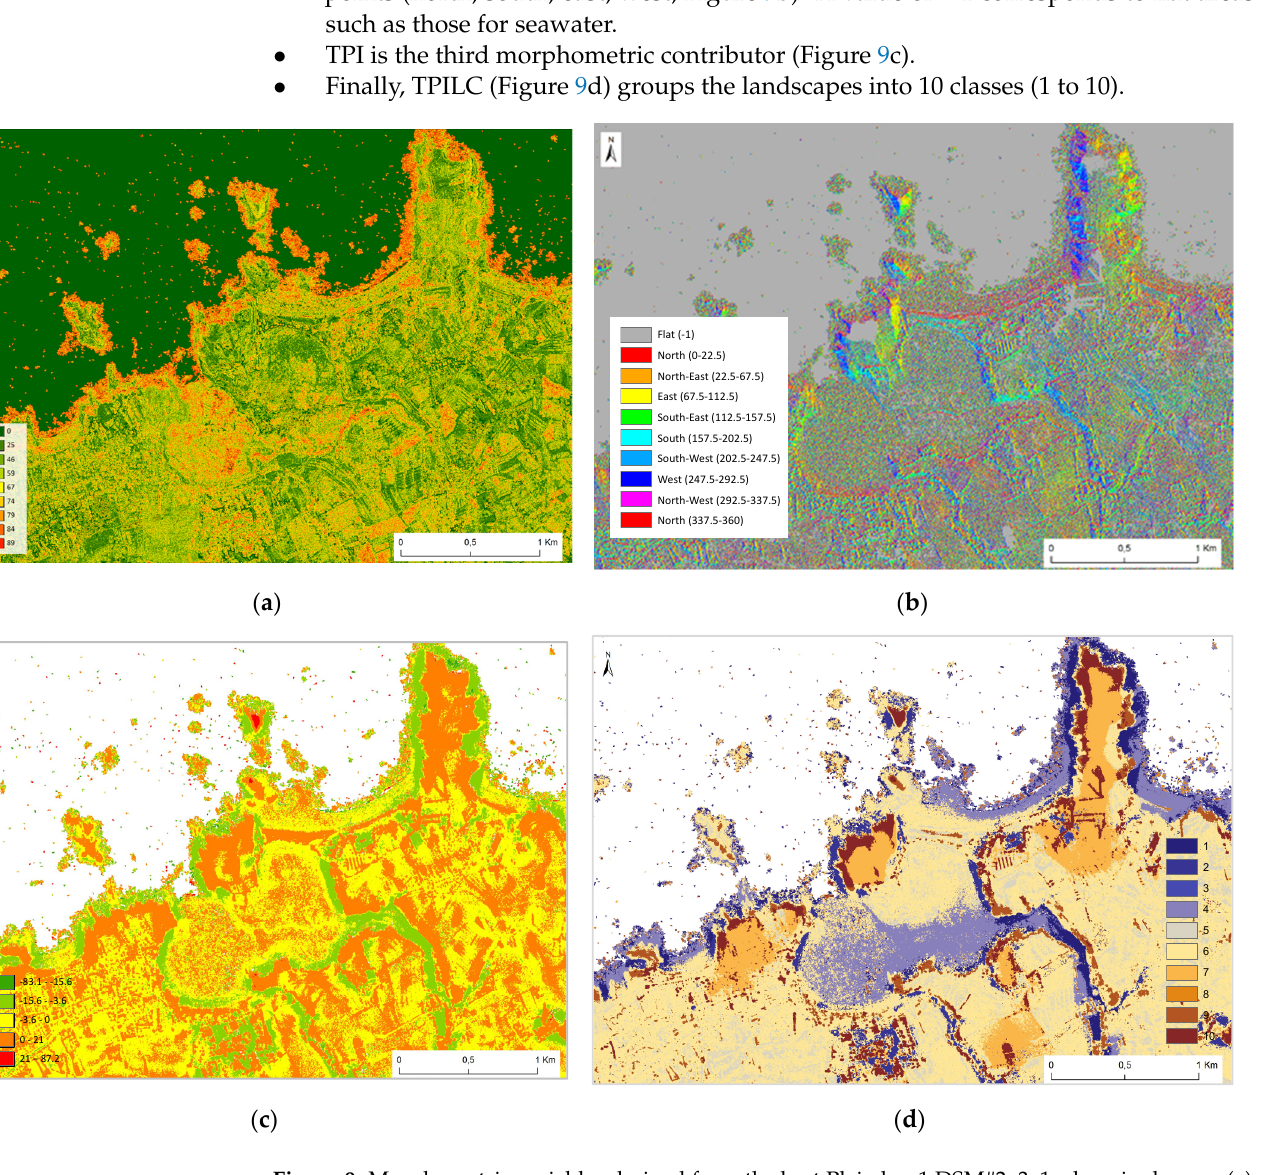
Figure 8. Ellipsoidal mean and standard deviation height at the class level on the sub–study site from the three best digital surface models.